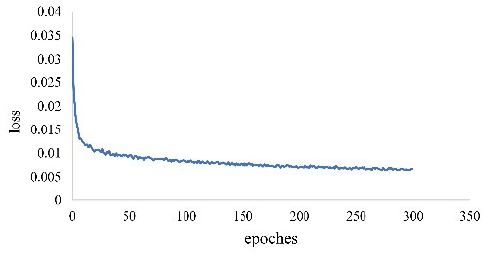
Figure 10. Curve of objectness loss.